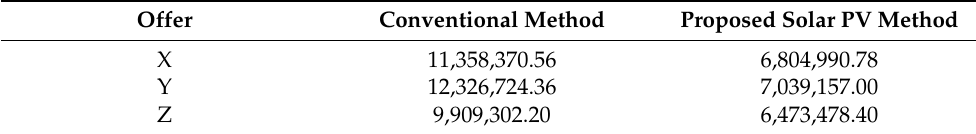
Table 5. TOC of competing